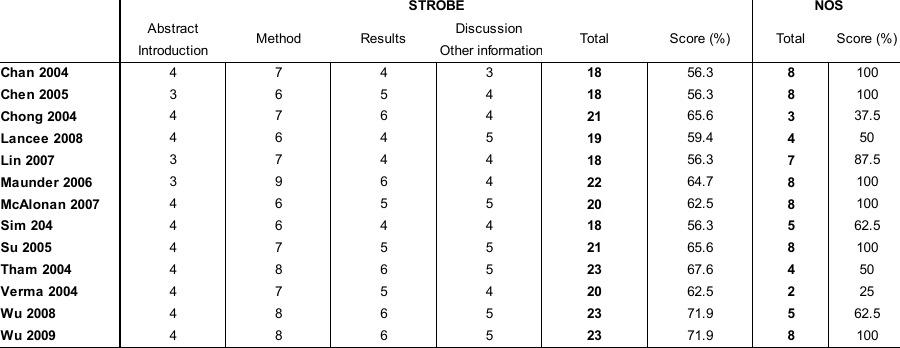
Figure A2. Quality of articles using the “STrength-ening the Reporting of OBservational studies in Epidemiology” (STROBE checklist).